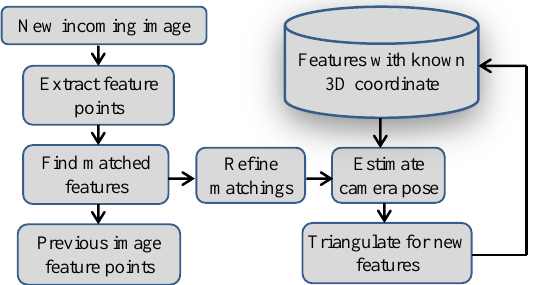
Figure 2. Overview of proposed approach.